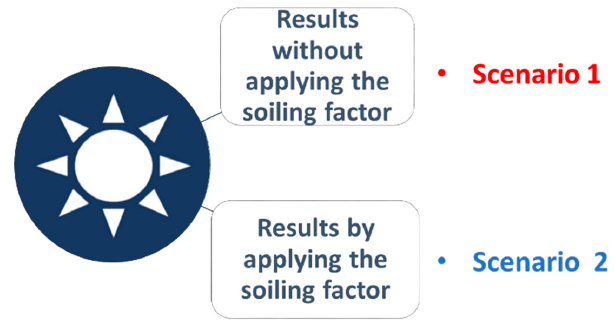
Figure 2. Scenarios proposed for evaluating the production difference.